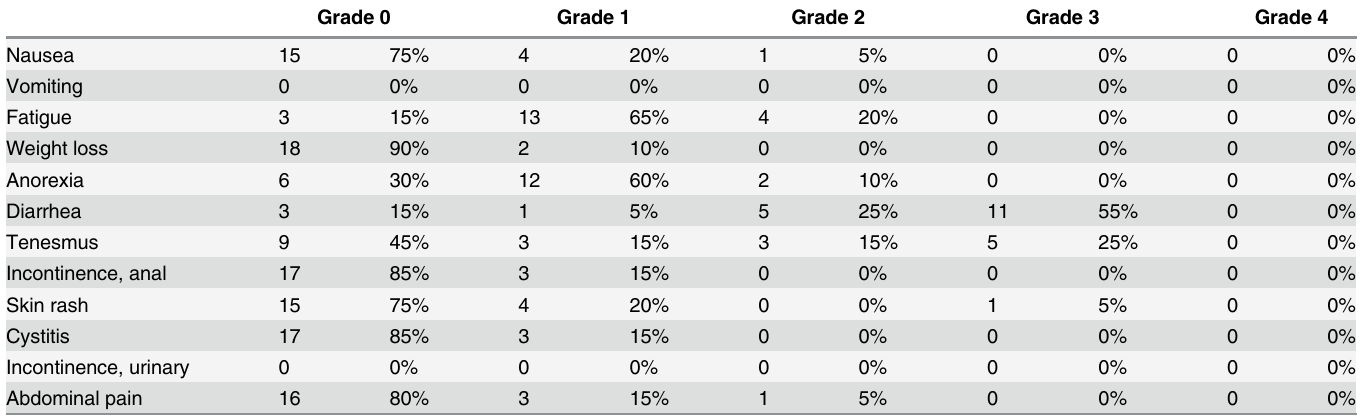
Table 2. Prospective evaluation of acute toxicity (n =